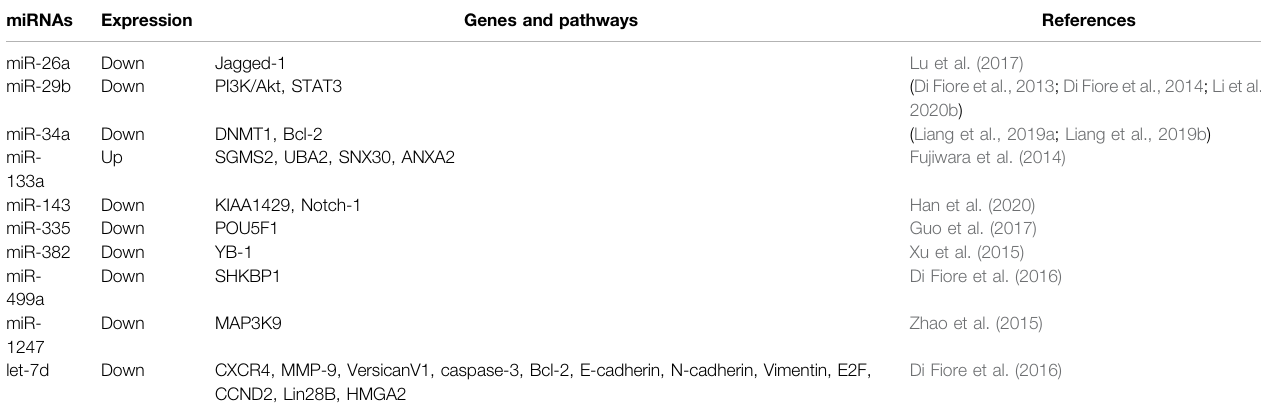
TABLE 1 | miRNAs regulate CSCs in